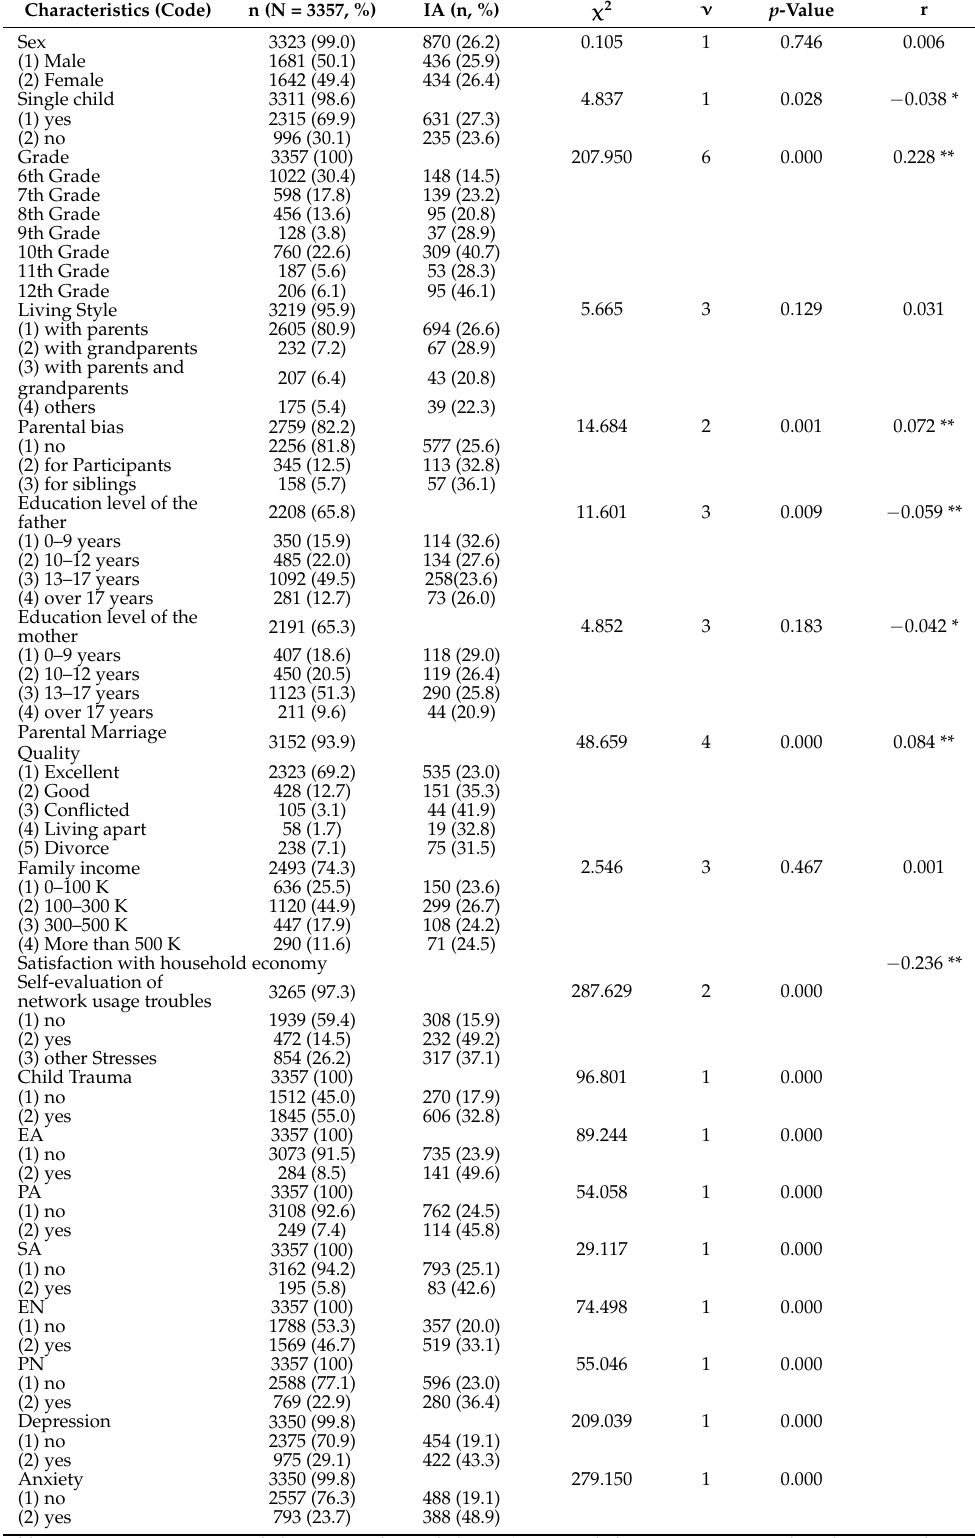
Table 1. Comparison of the differences in the prevalence of Internet addiction between